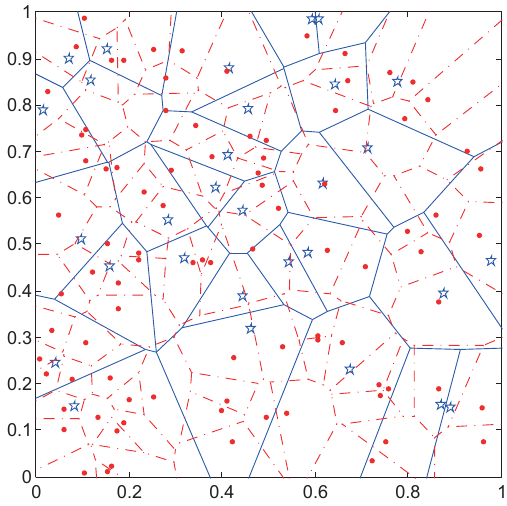
Figure 1. The spatial locations and coverage of macro base stations (MaBSs) and small base stations